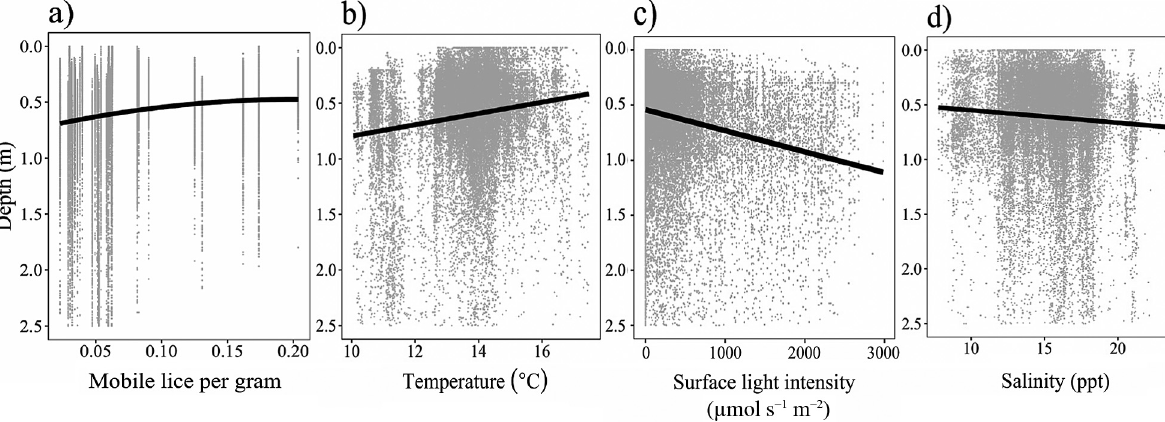
Fig. 4. Raw data of Salmo trutta depth registrations (grey) plotted against the 4 parameters: (a) mobile lice per gram of fish ( L i MOB ), (b) surface temperature ( T t up ), (c) surface light intensity (log C t ) , and (d) surface salinity ( S t up ), included in the best-fitting model for depth use (Table 3), fitted with a smoothing line (black)